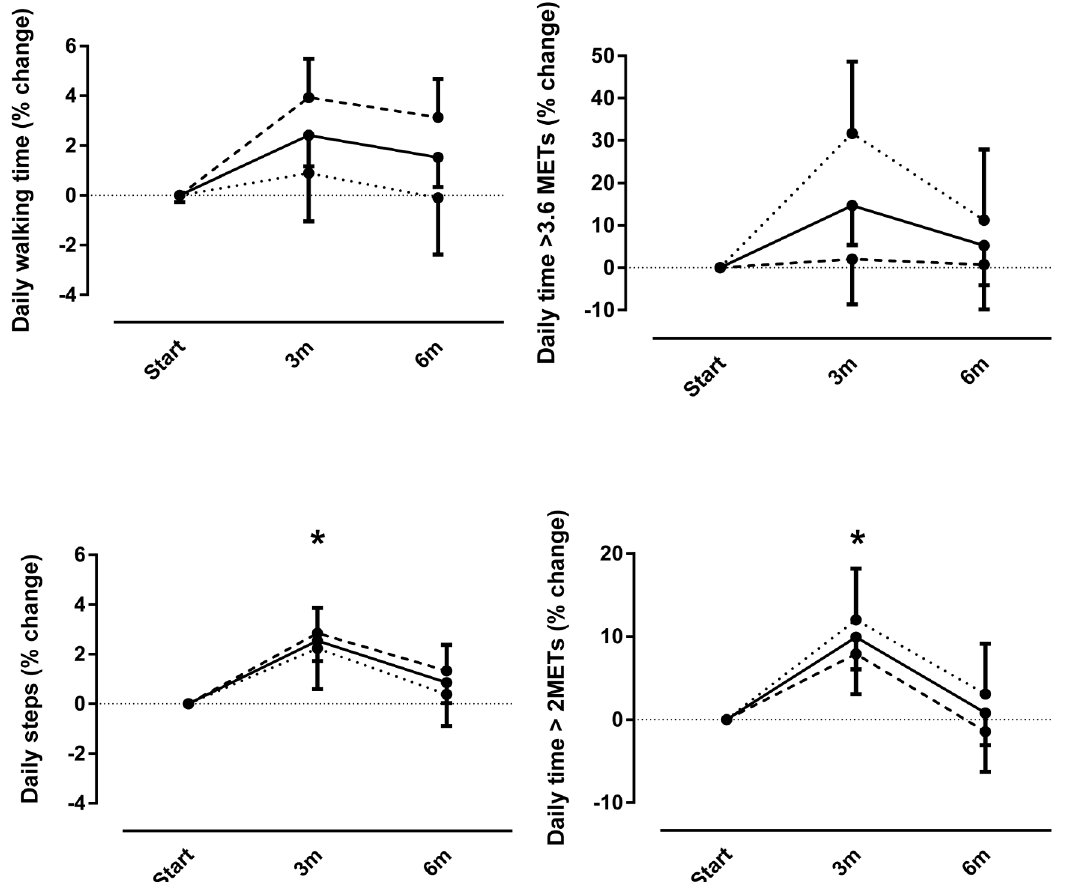
Fig 2. Relative changes in daily time spent walking, daily steps, daily time spent in at least moderate intense activities ( > 3.6 metabolic equivalents) and at least mild intense activities ( > 2.0 metabolic equivalents) after three months (3m) and after six months of rehabilitation (6m) compared to baseline. Data are expressed as percentage of change of least square means compared to baseline. No intervention * time effects were observed. * indicates time effect for the whole group (p < 0.05 compared to baseline).